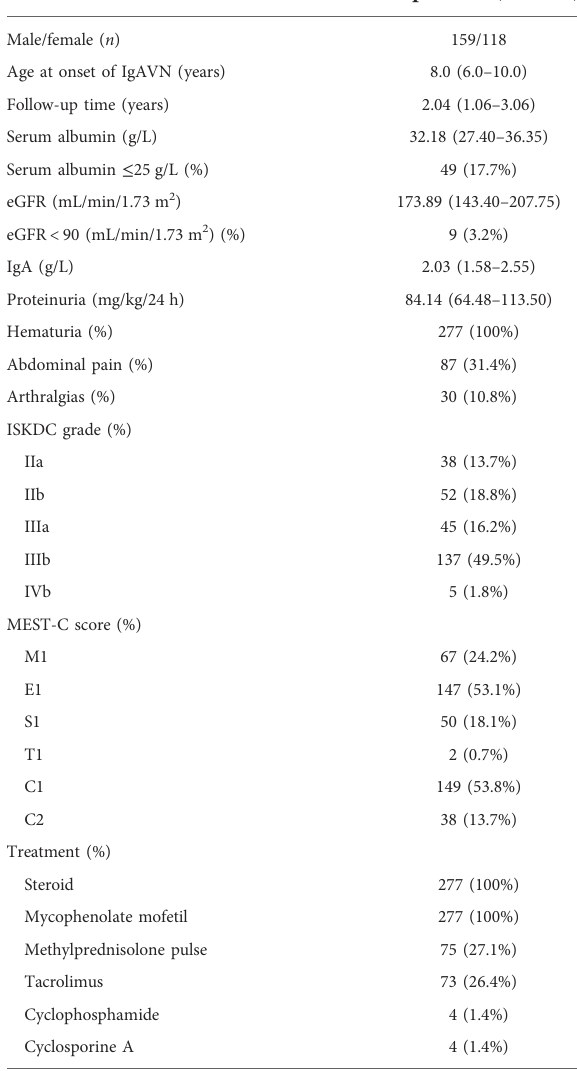
TABLE 1 Baseline characteristics of the study